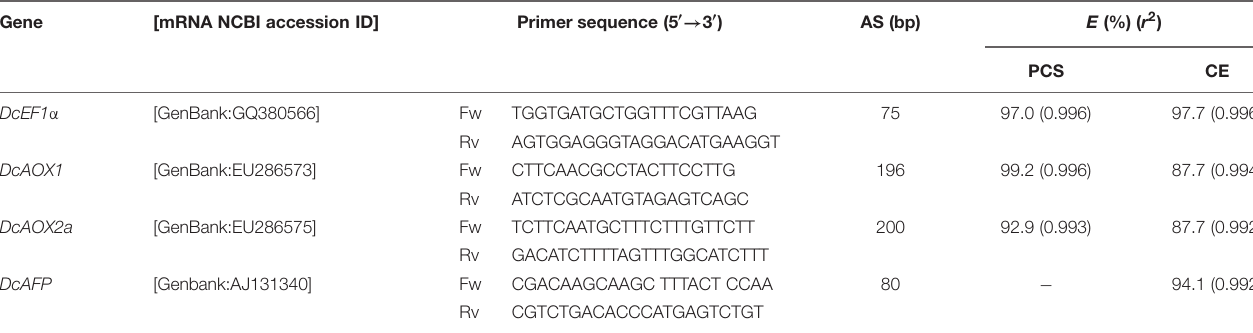
TABLE 1 | Primers used in RT-sqPCR and